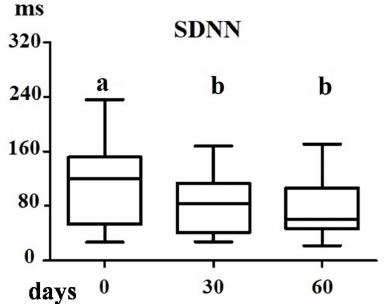
Figure 4. Comparison between mean values in milliseconds (ms), as a function of days, in relation to the SDNN value, before and after the rhinoplasty surgical procedure. Different letters (“a” and “b”) along a column with significant difference at 5% level.